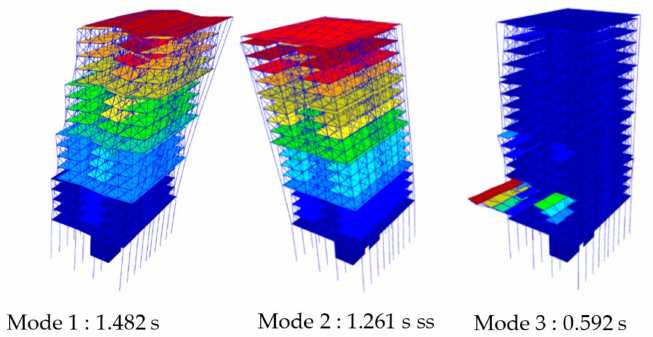
Figure 15. Vibration shapes of the first modes of the concrete hyperstructure with substructures connected only to the hyperfloors. Shapes are scaled with a ratio of 13.8. Mode 1 ( left ) is the first mode in the N–S direction. Mode 2 ( center ) is the first mode in the E–W direction. Mode 3 ( right ) is the next mode of vibration participating to the MPMR. The next 15 modes of vibration are all modes were only the substructures vibrate.